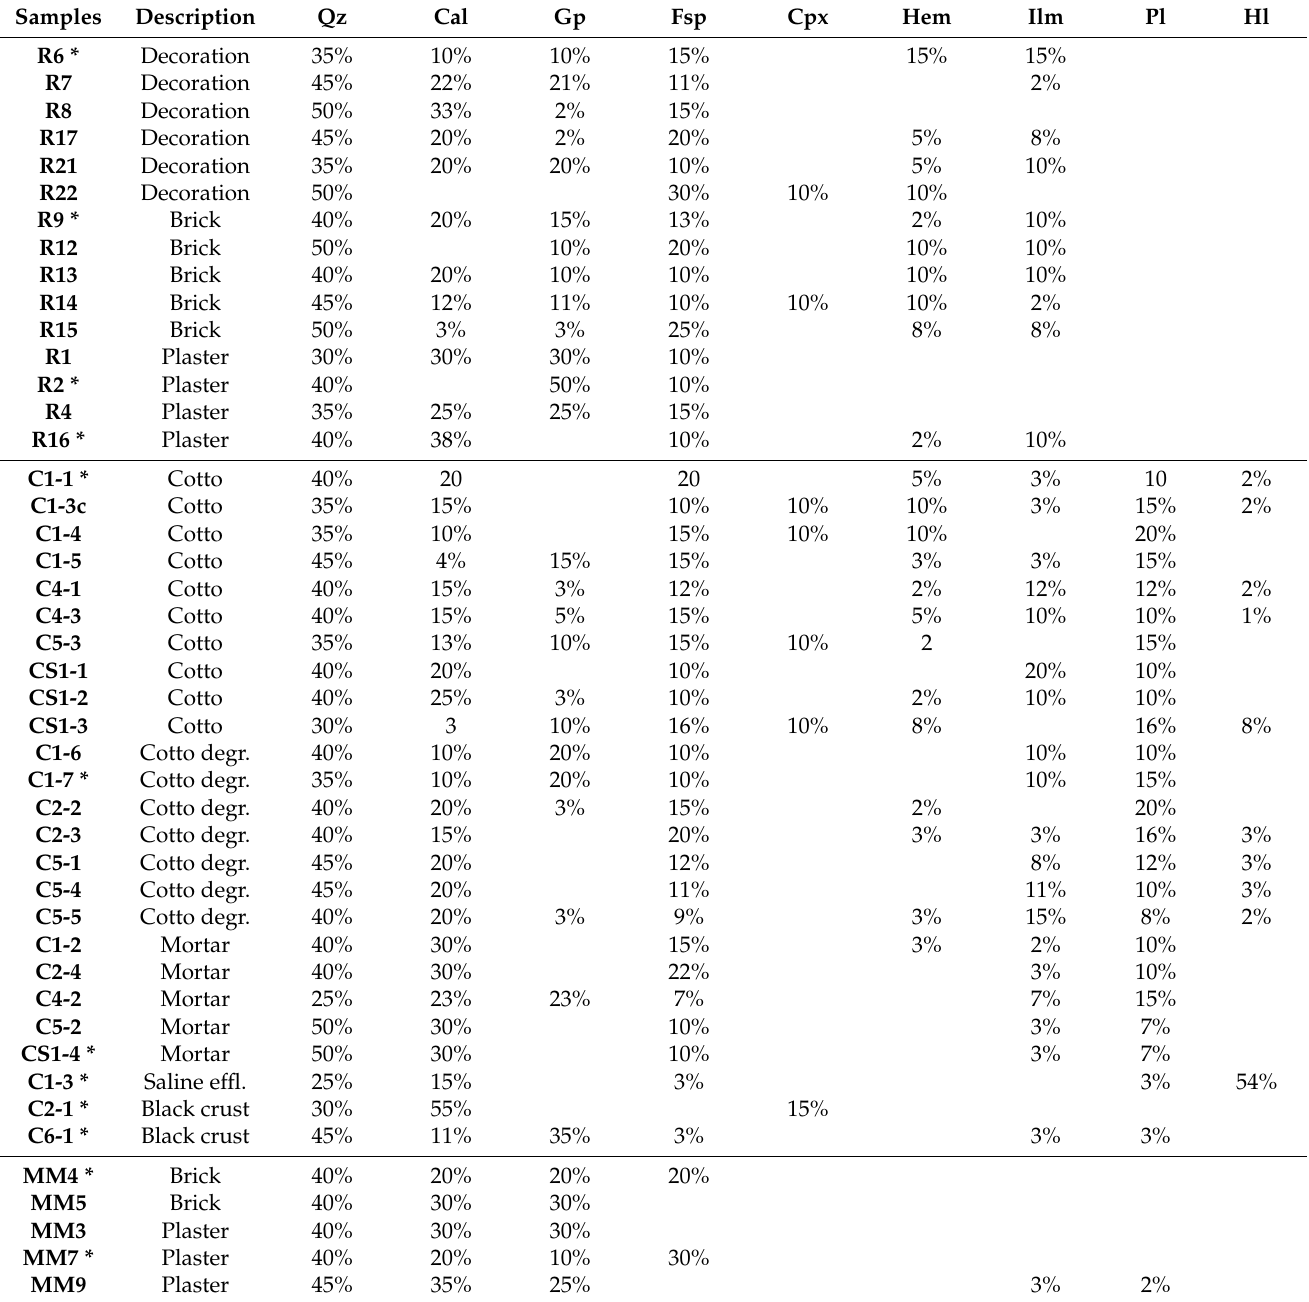
Table 3. XRPD data of all samples analyzed for the three different sampling sites (R = samples from Palazzo Roverella; C = samples from cloister of Santa Maria delle Grazie; MM = samples from the church of San Andrea). The symbol * highlights the samples for which the diffractograms are shown in Figure 5. The abbreviations are as follows as requested by Whitney [40]: Qz = quartz; Cal = calcite; Gp = gypsum; Fsp = feldspar; Cpx = clinopyroxene; Hem = hematite; Ilm = ilmenite; Pl = plagioclase; Hl =